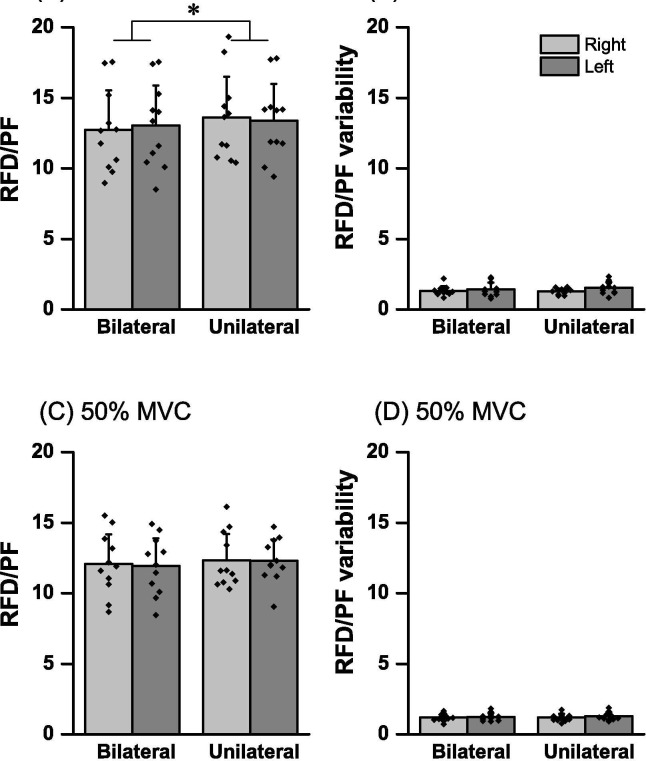
Mean rate of force development (RFD) to peak force ratio (RFD/PF) in right- (gray bar) and left-hand (dark gray bar) for bilateral and unilateral contractions.Dot presents the value for each individual. (A) mean RFD/PF of 30% of maximal voluntary contraction (MVC) target, (B) RFD/PF variability of 30% of MVC target, (C) mean RFD/PF of 50% of MVC target and (D) RFD/PF variability of 50% of MVC target. * show main effect (p < 0.05).